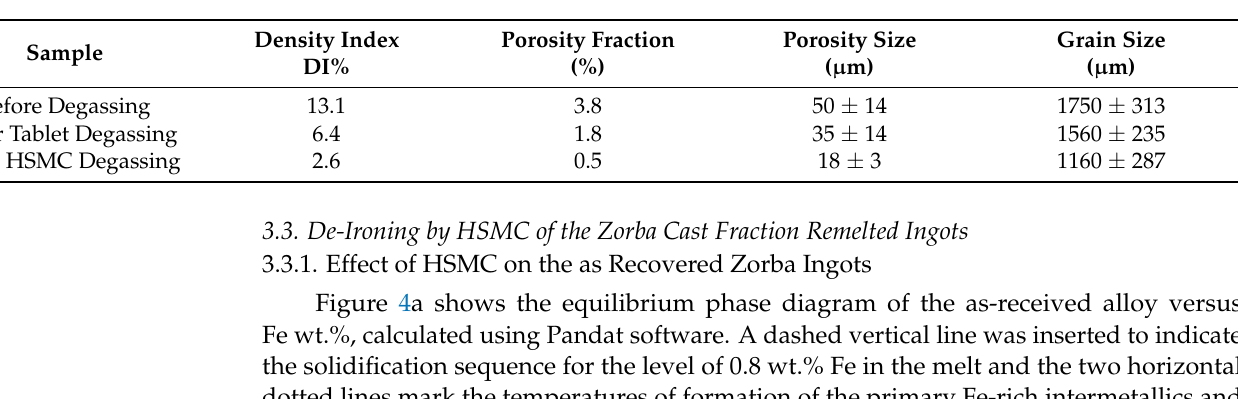
Figure 3. Optical micrographs of aluminum alloy recovered from Zorba Cast Fraction showing grain size ( top ) and porosity content ( bottom ) for: ( a ) without degassing; ( b ) degassing with tablet; and ( c ) degassed with high-shear melt conditioning. Table 2. Microstructural features of TP1 samples before and after degassing of aluminum alloy recovered from the Zorba cast